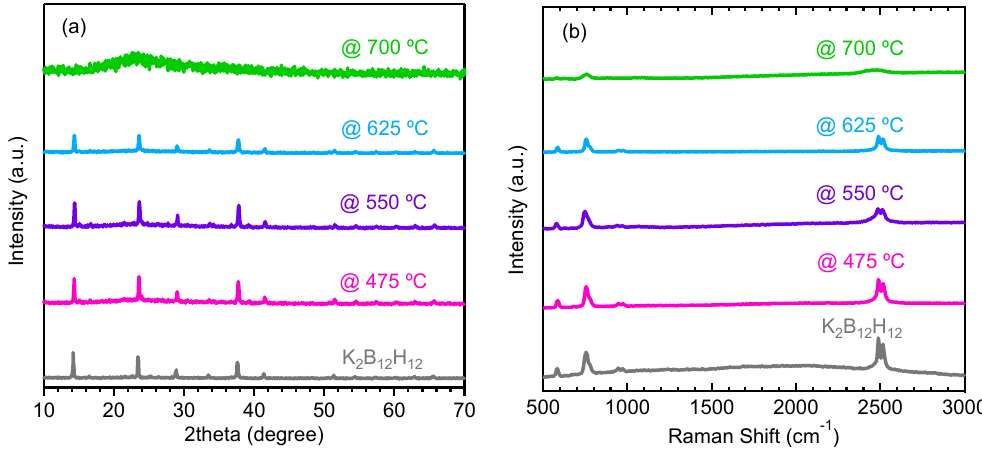
Figure 8. Ex-situ ( a ) XRD patterns and ( b ) Raman spectra of anhydrous K 2 B 12 H 12 as synthesized and heated up to respective temperatures.